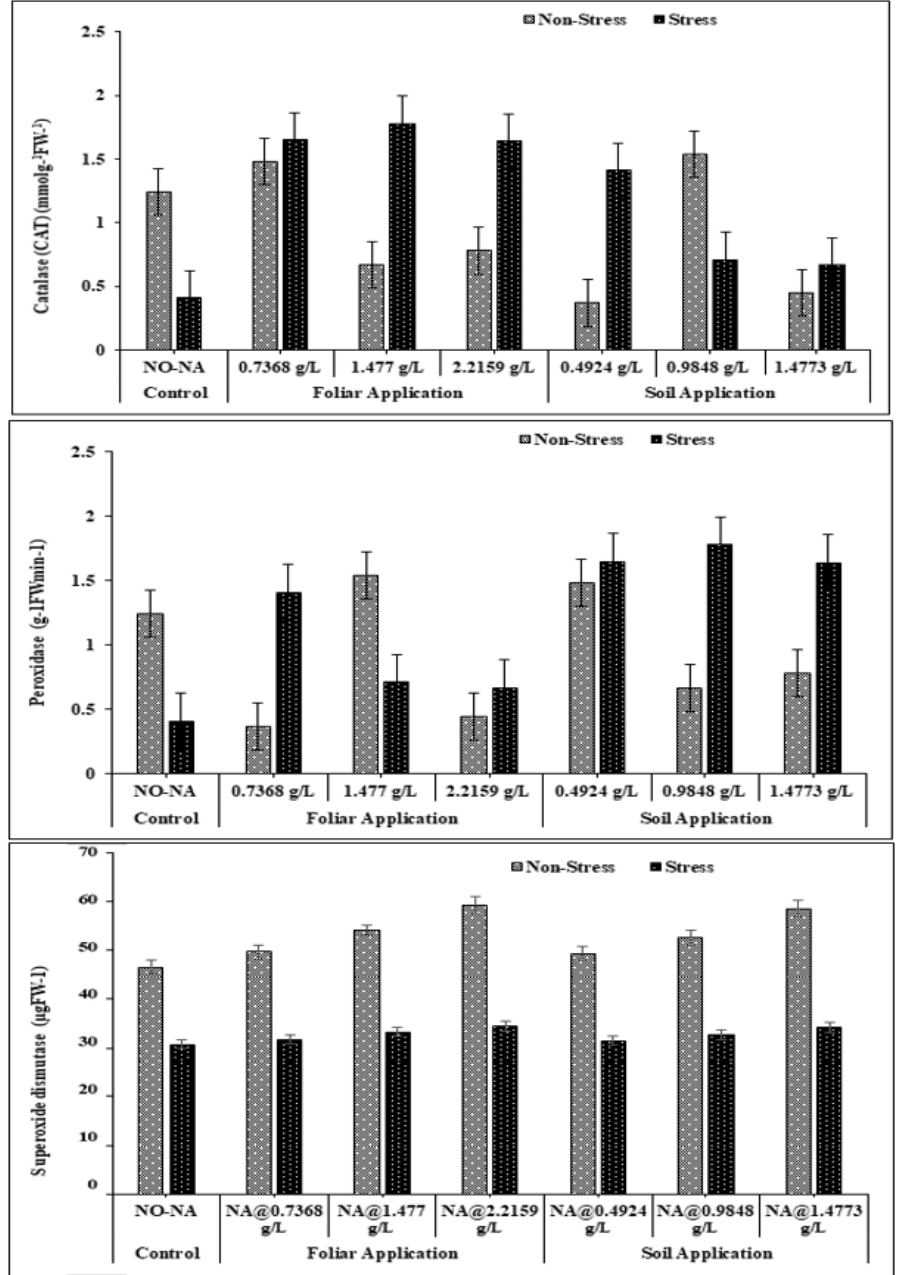
Figure 5. Effect of exogenously applied nicotinic acid on catalase (CAT) (mmolg − 1 FW − 1 ), peroxidase (POD) g − 1 FWmin − 1 ), superoxide dismutase (SOD) at anthesis stage of the plant under control and water deficit stress levels.